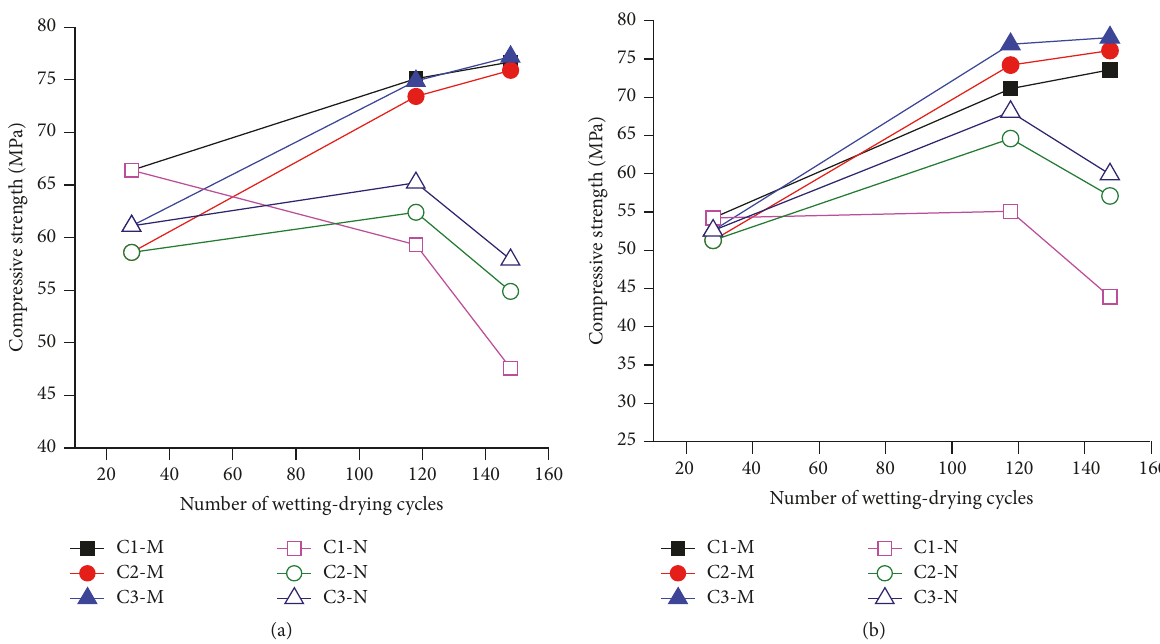
Figure 8: (a) Compressive strength of the concrete during a sulphate attack test when using standard curing. (b) Compressive strength of the concrete during a sulphate attack test when using temperature match